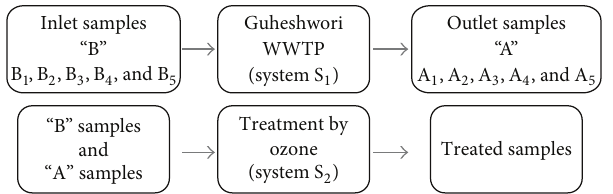
Figure 1: Schematic scheme of sampling and treatment of wastewater.